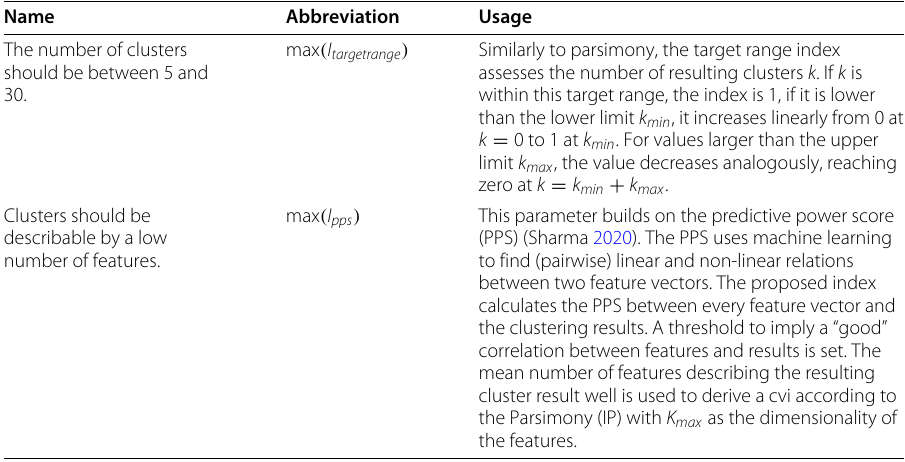
Table 6 New indices for municipality clustering